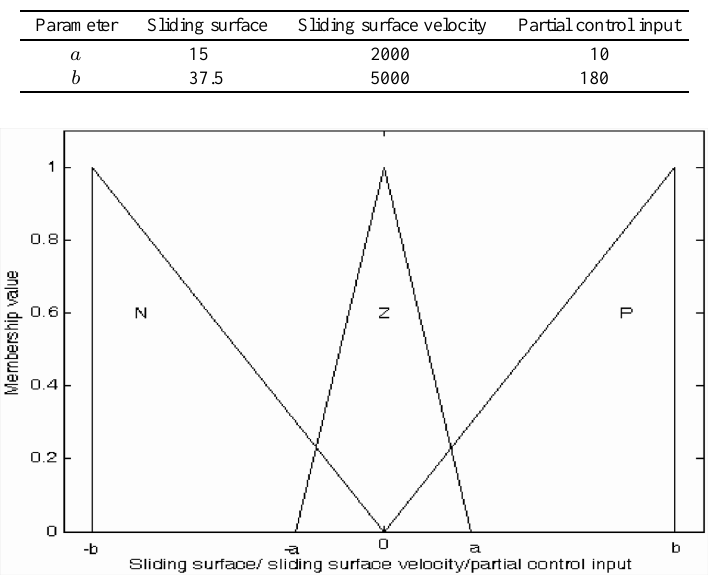
Fig. 3. Fuzzy sets for sliding surface/ sliding surface velocity/partial control